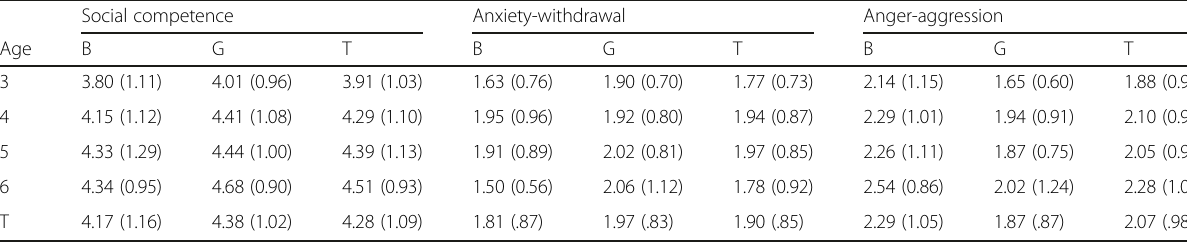
Table 3 Mean scores (standard-deviations) in the SBCE (5 items subscales) for age and sex Social